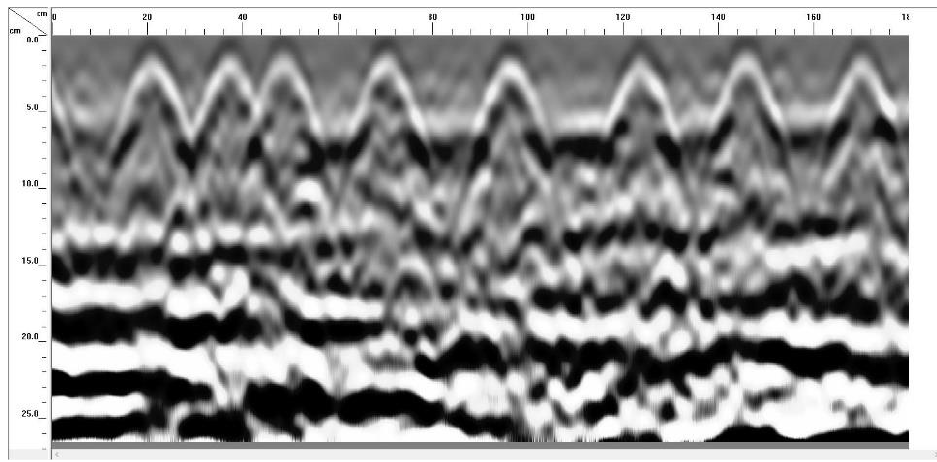
Figure 12. Radargram of built-in reinforcement.